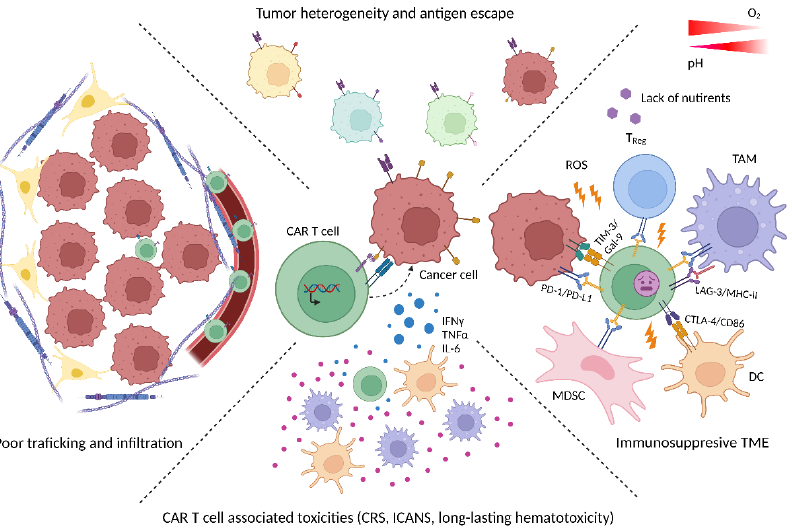
Figure 1. Current barriers in CAR T cell therapy. Clinical efficacy of CAR T cell therapy can be limited by various factors. The heterogeneity of tumors can give rise to variants that do not carry the target antigen on their surface. Immune checkpoint molecules (e.g., PD-L1 on tumor and/or stroma cells that binds to PD-1 on CAR T cells) can slow down anti-tumor activity. Overall, CAR T cells enter an immunosuppressive TME with tolerance-promoting cells such as myeloid-derived suppressor cells (MDSCs), tumor associated macrophages (TAM) or T Regs and inhospitable metabolic conditions (i.e., hypoxia, acidosis, oxidative stress, depletion of critical nutrients, etc.). In fact, the TME and the tumor cells within can represent an impermeable obstacle for CAR T cells due to their poor trafficking resulting in an insufficient infiltration of tumor tissue. In addition, CAR T cells ’ (over)activation can lead to severe and potentially life-threatening toxicities with cytokine release (CRS); immune effector cell-associated neurotoxicity syndrome (ICANS) and long-lasting hematotoxicity as the most common.